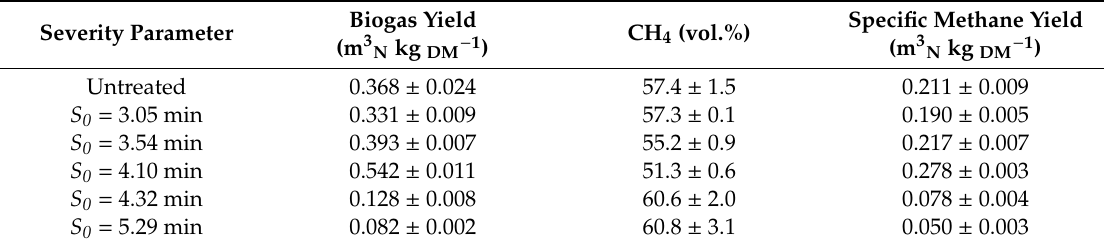
Figure 7. Cumulative specific methane production of rice straw and steam-exploded rice straw. Error bars indicate standard deviation for three repetitions. Table 3. Biogas yield, methane content, and specific methane yield of the untreated rice straw and steam-exploded rice straw after 35 d (mean with standard deviation of three repetitions).